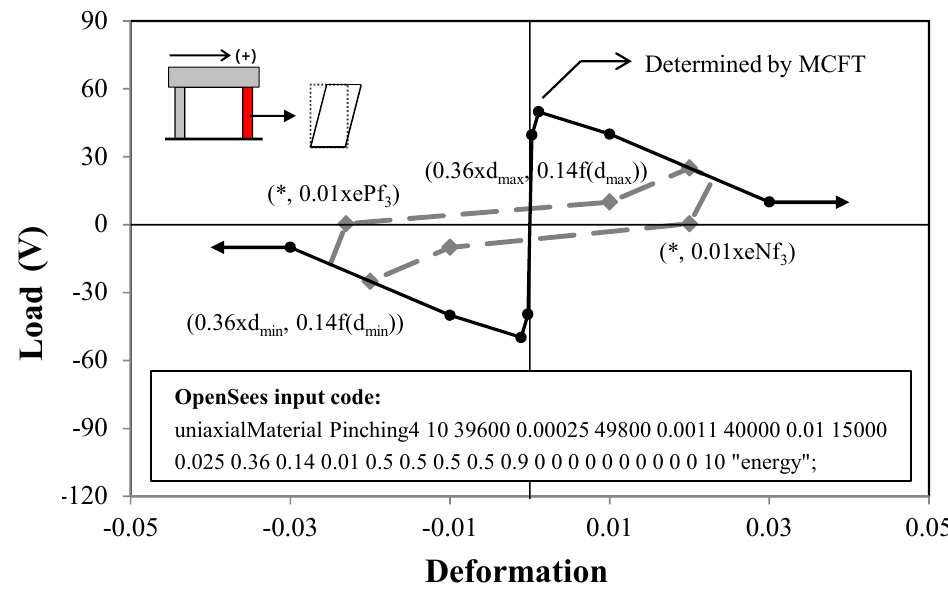
Figure 12. Hysteretic shear behavior of reinforced concrete column.